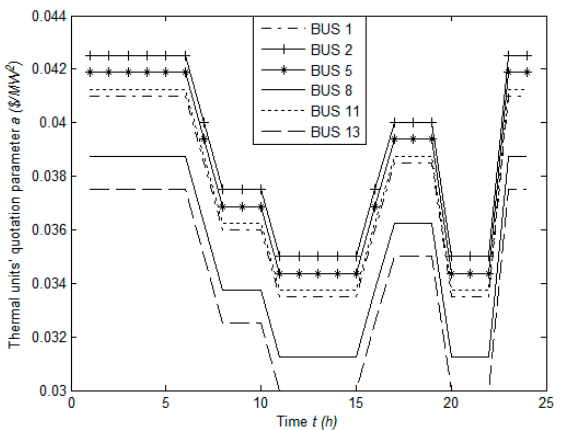
Figure 7. Thermal generators’ quotation parameter a j ( t ).